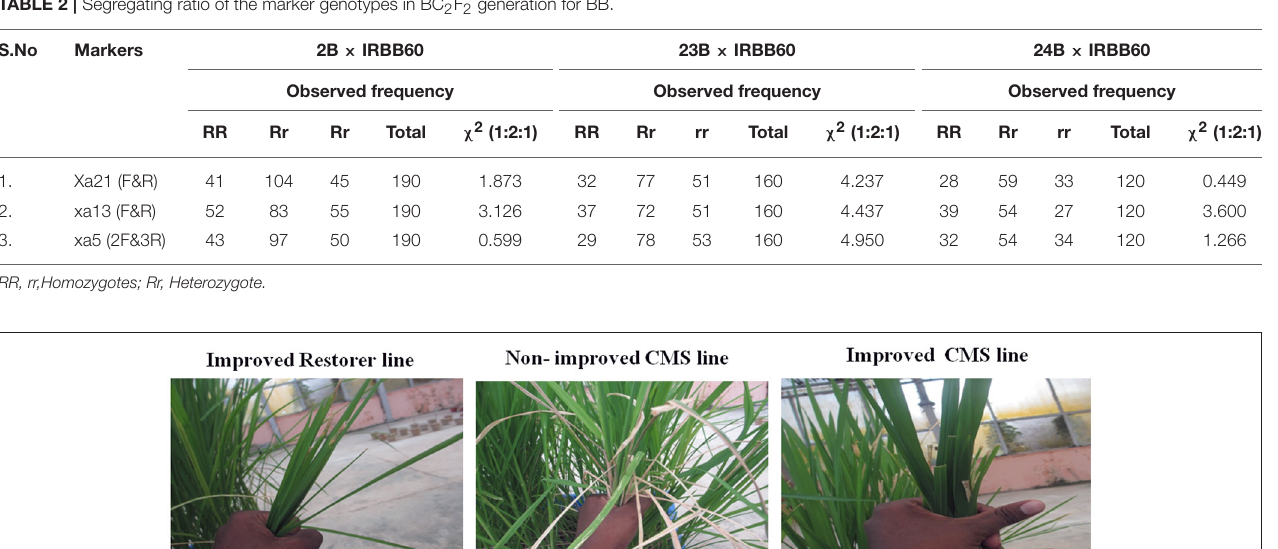
not only to pyramid both recessive and dominant genes